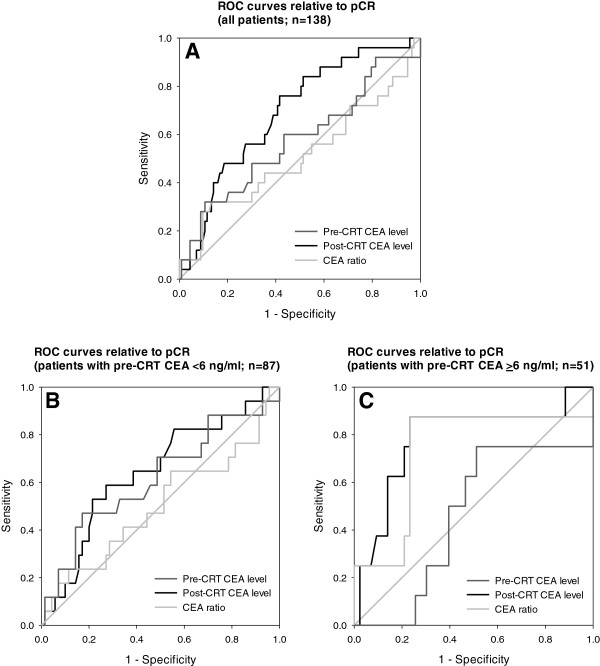
Receiver operating characteristic curves of various CEA parameters relative to pathologic complete response. (A) For all patients (n = 138), the area under the curves (AUCs) were 0.575 (p = 0.243), 0.691 (p = 0.003) and 0.508 (p = 0.894) for pre-CRT CEA, post-CRT CEA and CEA ratio, respectively. (B) For those with pre-CRT CEA <6 ng/ml (n = 87), the AUCs were 0.617 (p = 0.135), 0.644 (p = 0.066) and 0.501 (p = 0.991) for pre-CRT CEA, post-CRT CEA and CEA ratio, respectively. (C) For those with pre-CRT CEA ≥6 ng/ml (n = 51), the AUCs were 0.459 (p = 0.717), 0.783 (p = 0.012) and 0.733 (p = 0.038) for pre-CRT CEA, post-CRT CEA and CEA ratio, respectively.